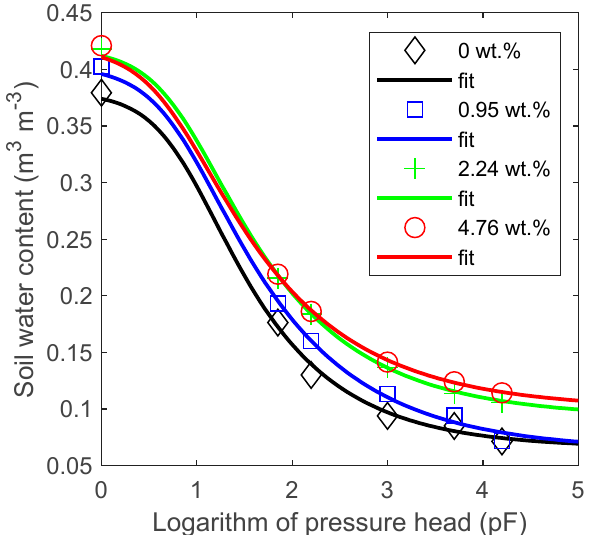
Figure 4. Water retention curves (symbols — experiment, solid lines — VG equation fit) of sandy soil amended with different doses (0.95, 2.24, and 4.76 wt.%) of sieved biochar ( φ < 2000 µ m). The addition of the sunflower husk biochar to sandy soil caused an increase in the value of θ S (soil moisture at saturation) and in the matric suction values corresponding to the wilting point (pF = 4.2). The correlation coefficients for all fits were very close to unity.